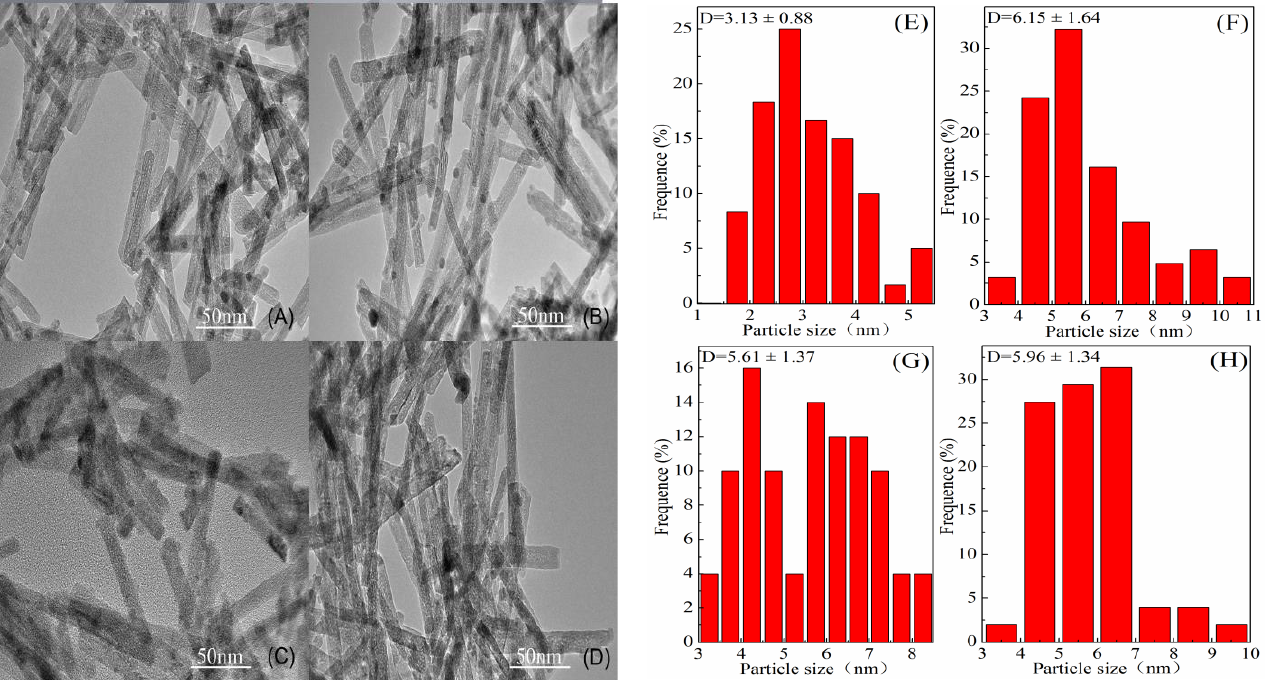
Figure 2. TEM micrographs and particle size distributions of the catalysts (( A , E ) Au/R-C; ( B , F ) Au/CM; ( C , G ) Au/CL; ( D , H ) Au/CML).